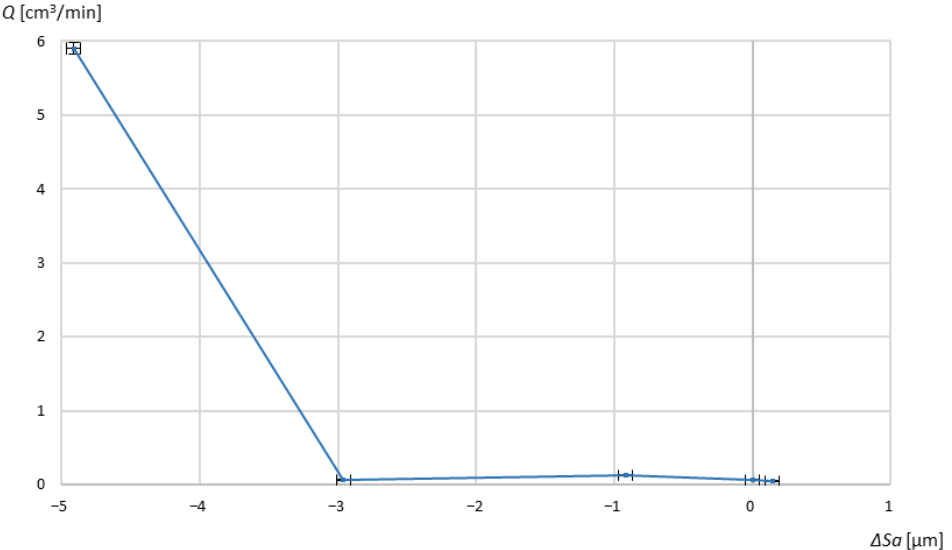
Figure 15. The value of leakage Q as a function of the difference in the value of the surface topography parameter Sa for a constant compressive force of 2280 N for the base surface with the value of Sa = 0.33 µ